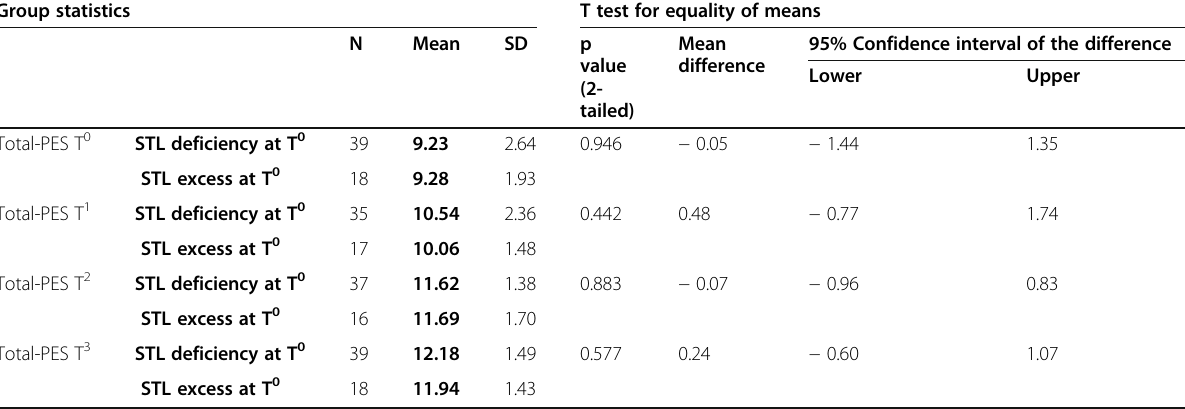
Table 2 Comparison of mean total-PES for all points in time, based on surplus, or deficiency of STL at T 0 . Equal variances were